Question: How would you classify this visualization?
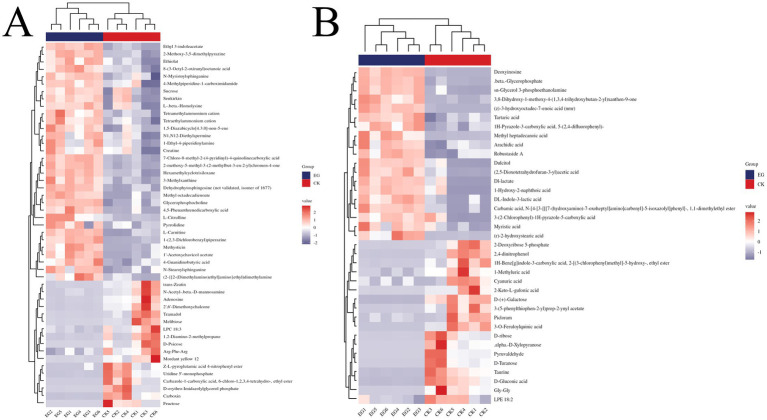
Answer: heatmap